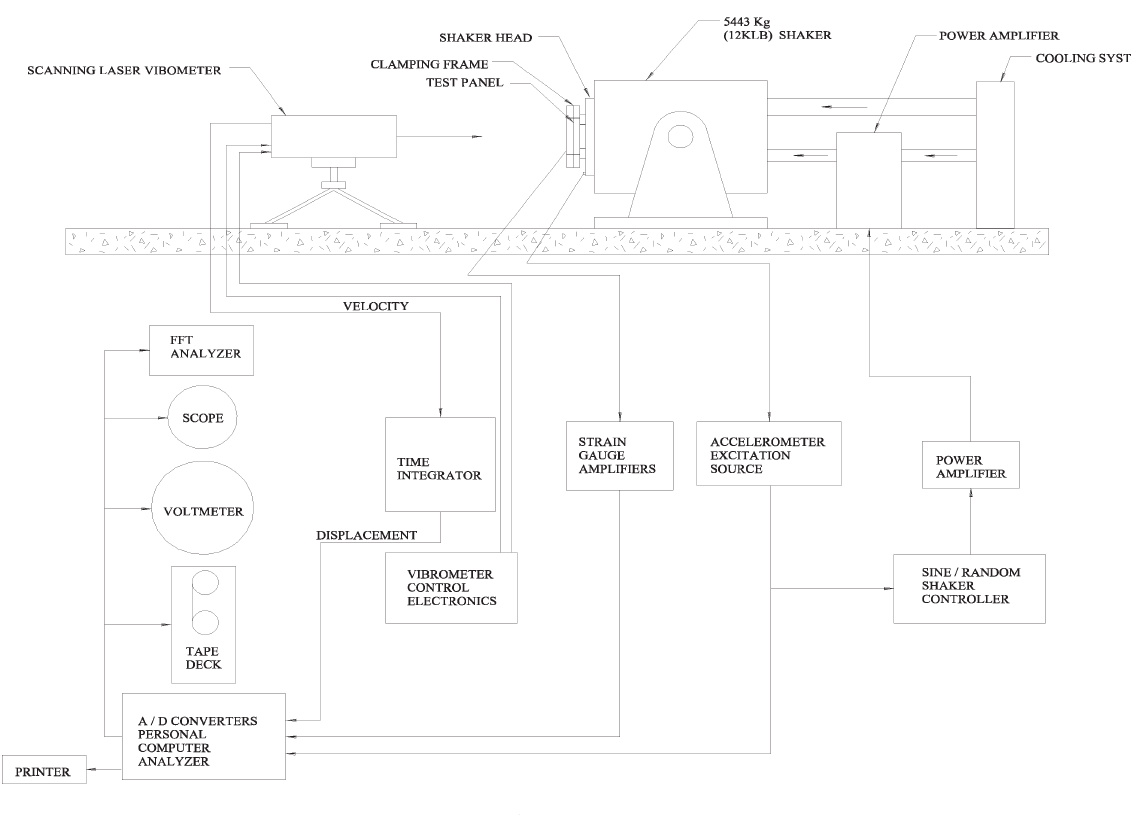
Fig. 3. Test set up.